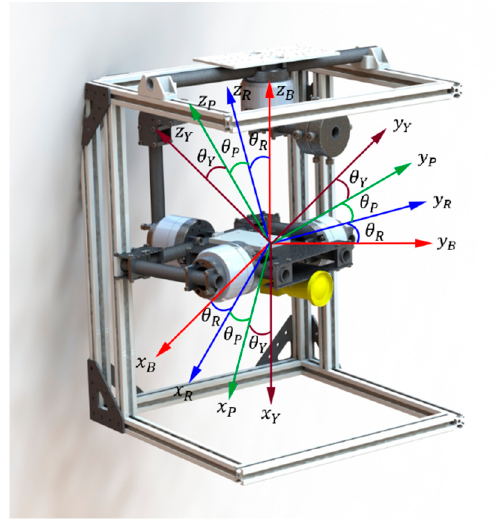
Figure 1. Configuration of a three-axis stabilized platform.